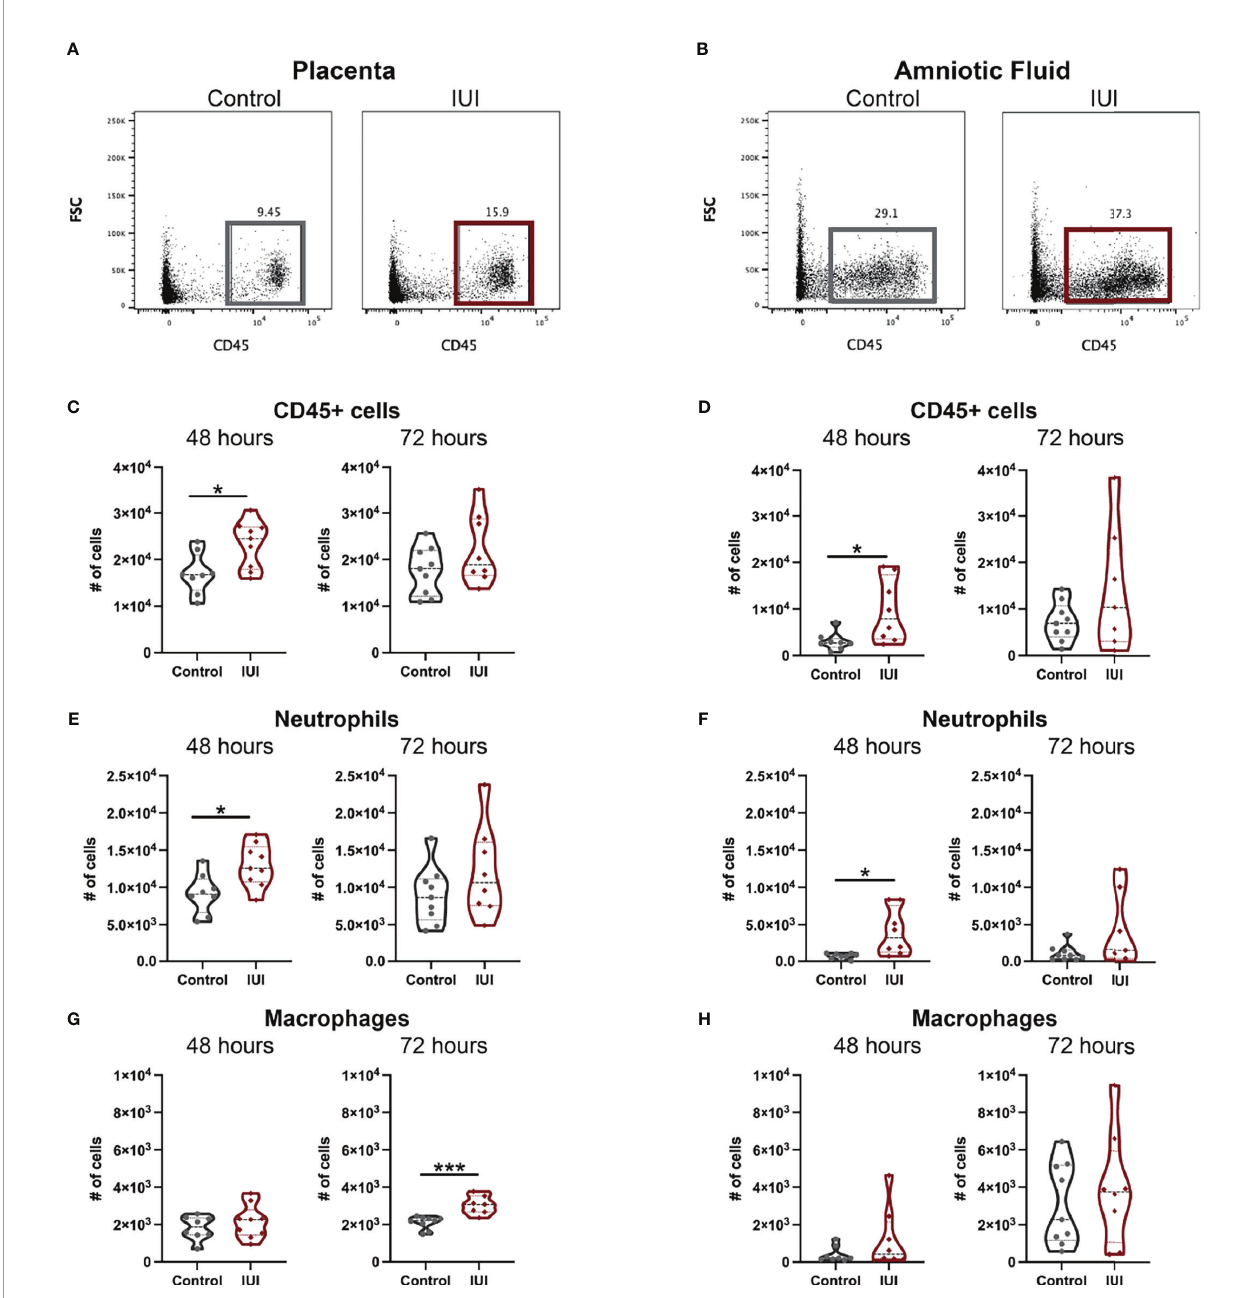
FIGURE 2 | Intrauterine in fl ammation increases leukocytes found in the placenta and amniotic fl uid. Placentae adjacent to the injection site and total amniotic fl uid were collected at 48 and 72 hours post-uterine injection and immune cells were analyzed by fl ow cytometry. Representative fl ow plots of CD45+ cells in